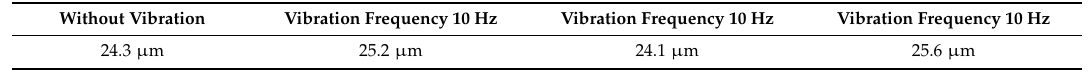
Table 2. Average grain size with different vibration frequencies.